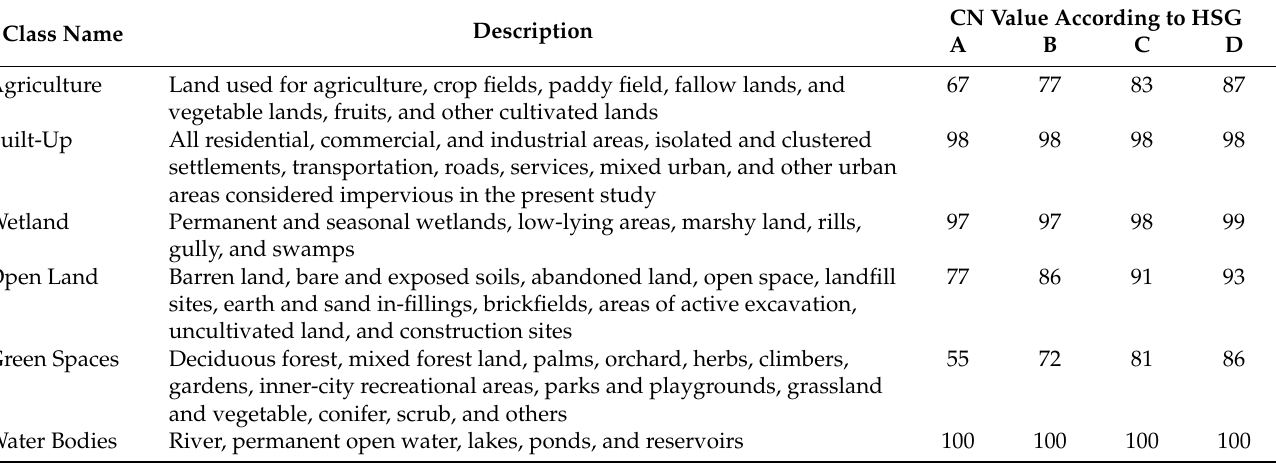
Table 3. LULC and their corresponding CN values assigned [86–89].